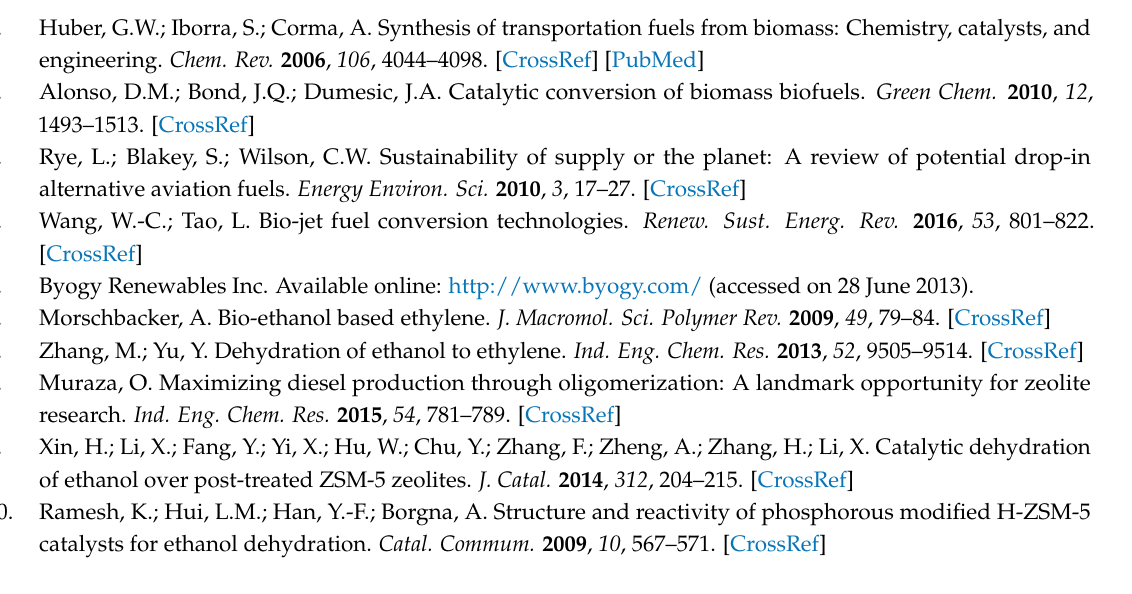
Figure S1: Powder XRD patterns of H-ZSM-5A, H-ZSM-5B, H-ZSM-5C, and H-ZSM-5D, Figure S2: Ethanol conversion obtained after 3 h on steam in dehydration of bioethanol over 2 g of molded H-ZSM-5A1, H-ZSM-5A2, H-ZSM-5A3, H-ZSM-5A4, and H-ZSM-5A5 catalysts at 250 ◦ C and 5 h − 1